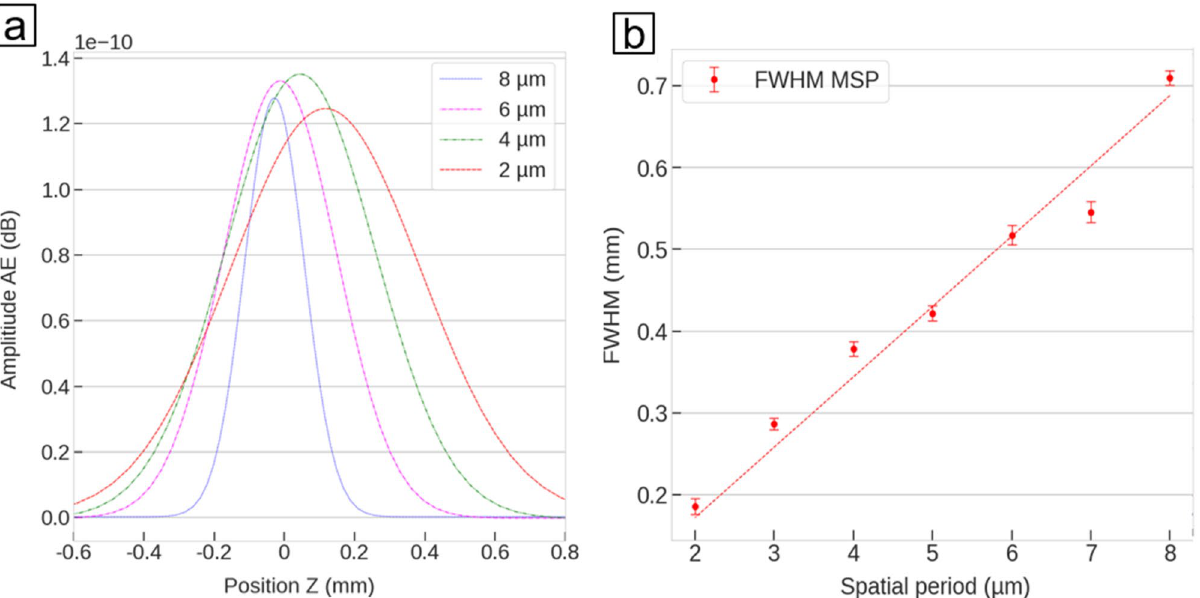
Figure 5. ( a ) MSP for different spatial periods, 8 µm, 6 µm, 4 µm and 2 µm approximated by a Gaussian function, ( b ) Change of the FWHM of the approximated sound curve for pulse energy 210